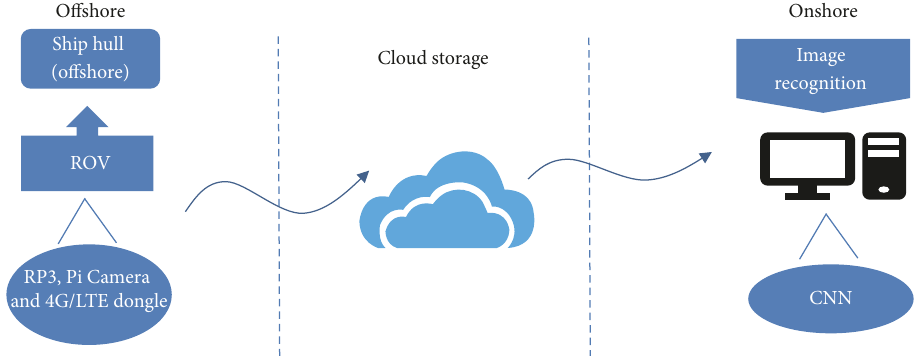
Figure 1: Proposed fouling recognition system design in this study.